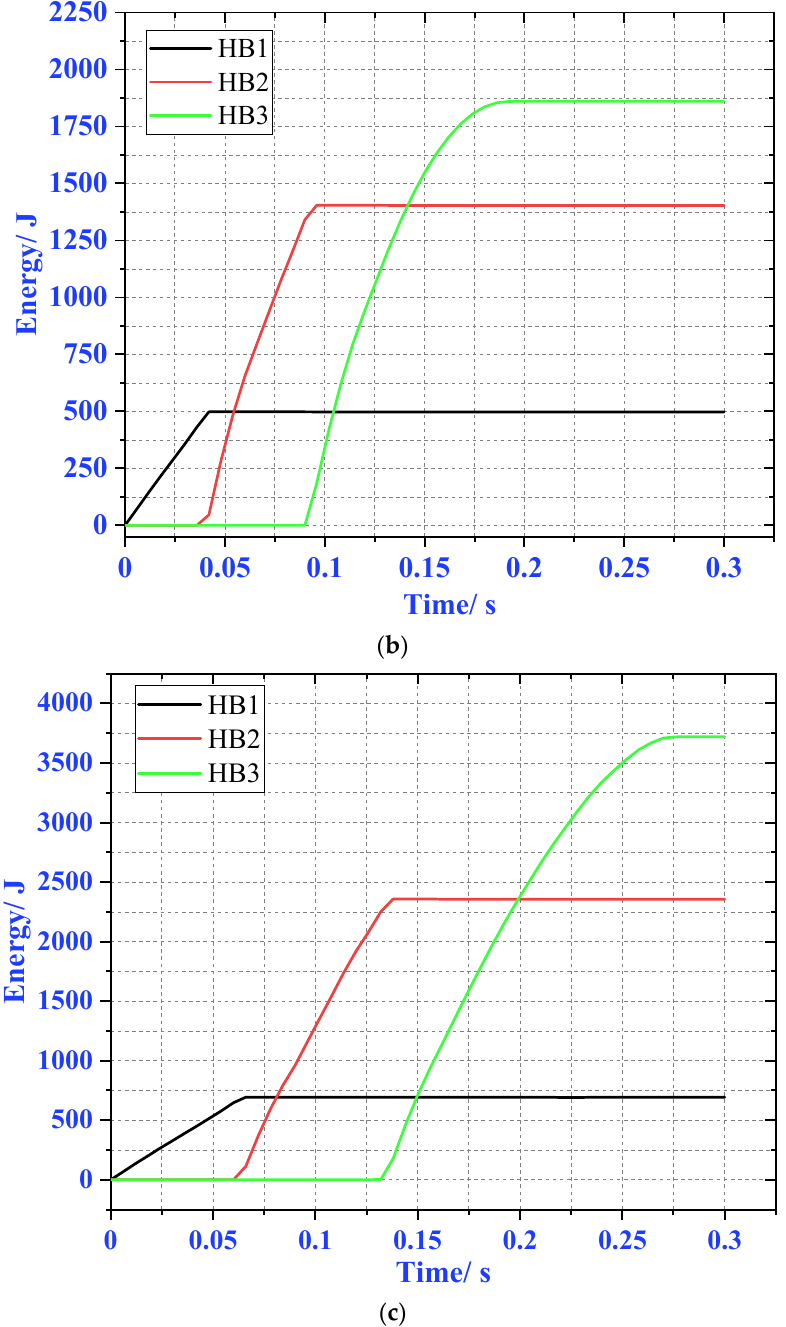
Figure 12. Energy absorption (EA) of three aluminum honeycombs (AHs) under three loads. ( a ) 300 kg, ( b ) 500 kg, and ( c ) 700 kg.